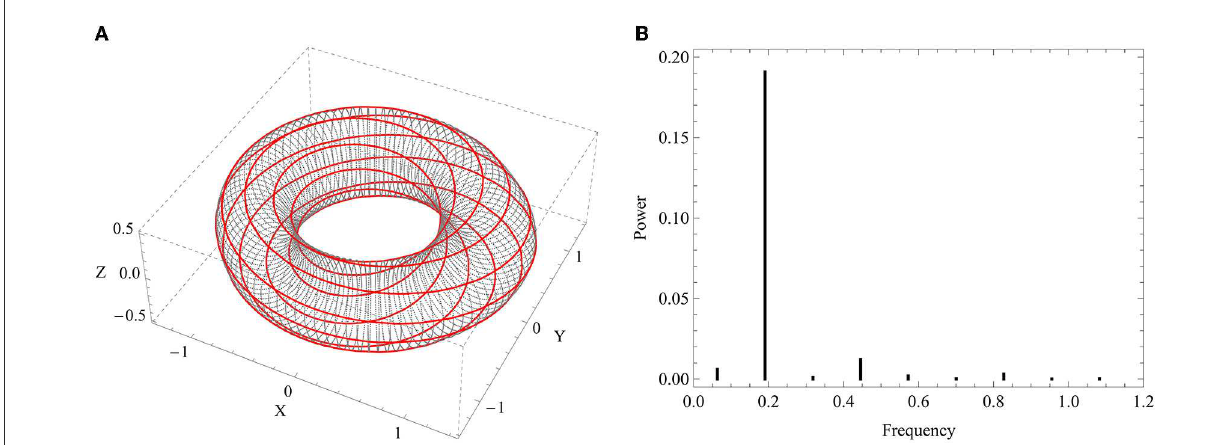
FIGURE5 (A) Periodic solution (red curve) on the resonant torus. The hidden geometry of the torus in the space XYZ , i.e., the Cartesian coordinates of the flow computed via toroidal remapping, is made visible using poloidal sections drawn as dotted and gray lines. (B) Power spectrum of the periodic trajectory, which contains equally spaced